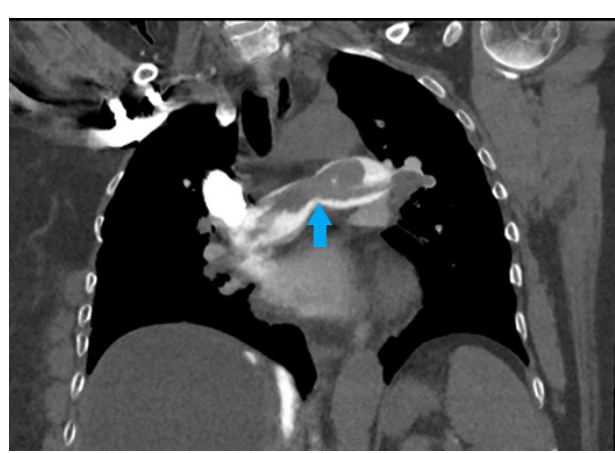
Fig. 3 - Computed tomography of pulmonary artery (coronal view). Arrow shows extensive clot burden in the pulmonary arteries with potential for distal